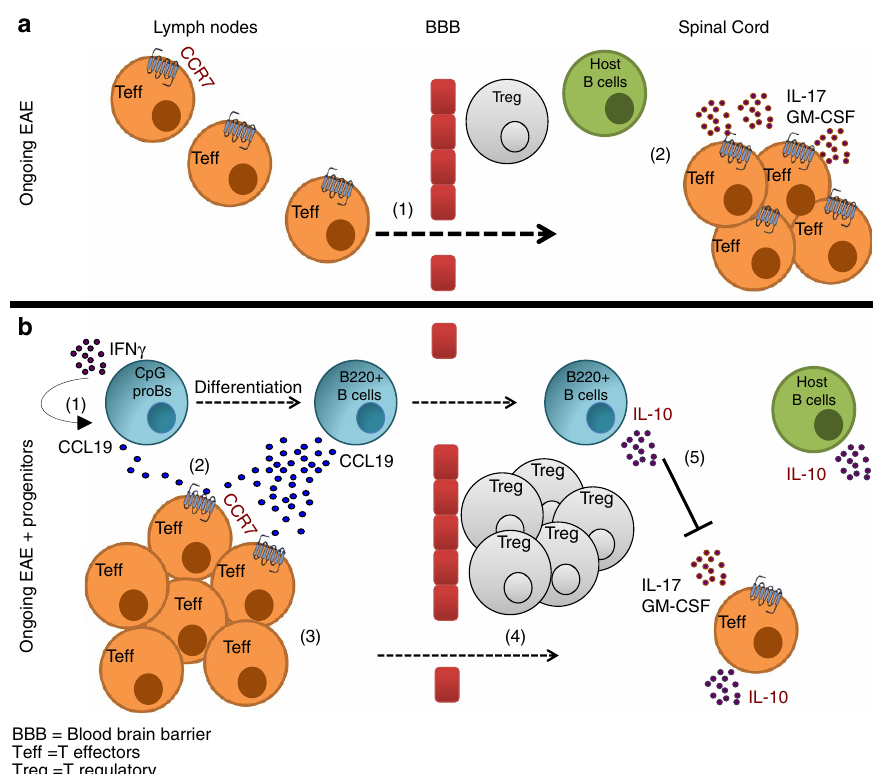
Figure 7 | Protection against EAE by CpG-proBs relies on cooperative action of their LN and spinal cord B-cell progeny. ( a ) At the onset of clinical signs of EAE in untreated mice, autoreactive Tcells migrate to the spinal cord (1) and release pathogenic cytokines IL-17 and GM-CSF (2). ( b ) In mice protected against EAE by adoptive transfer of only 60,000 CpG-proBs per recipient, the IFN- g -dependent release by CpG-proB’s progeny of CCL19 (1–2) anchors Tcells via CCR7 (3), leading to effector Tcells (Teff) accumulation in reactive LN. As a result, fewer Tcells reach the spinal cord (4). In the spinal cord, the CpG-proB’s progeny releases IL-10 (5), that reduces IL-17 and GM-CSF production by T cells, enhances Foxp3 þ Treg accumulation and triggers IL-10 release by host B